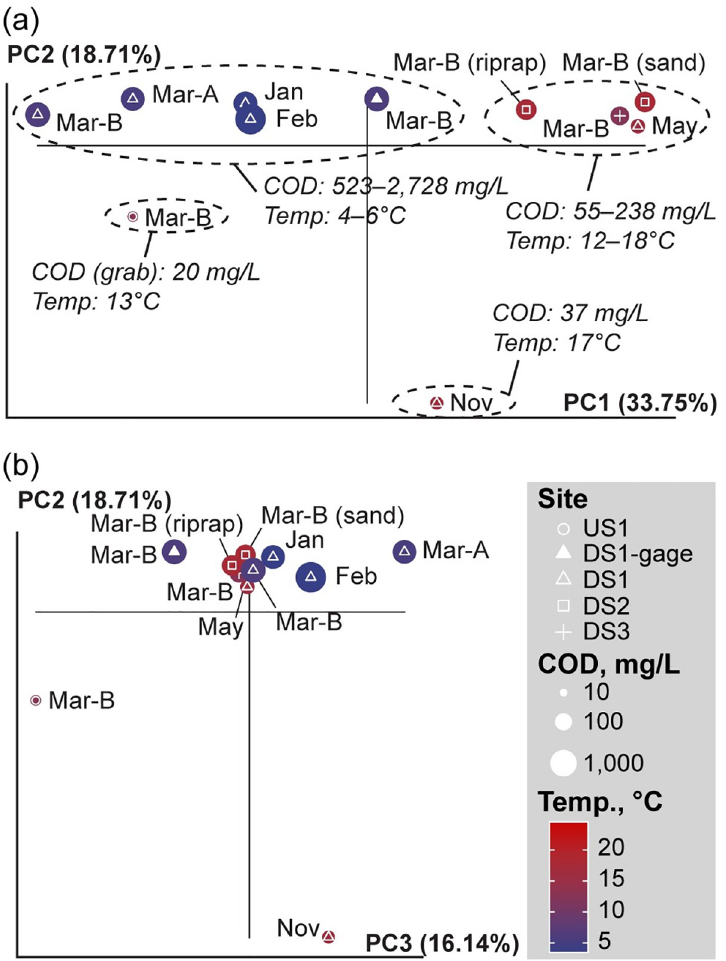
Fig 7. Principal coordinates analysis plot showing differences in biofilm community composition, based on PhyloChip results. (a) axes 1 and 2, and (b) axes 2 and 3. White symbol shapes distinguish sampling sites; point size reflects the log-10 mean 2-week flow-weighted COD concentration at each site (except at US1 site, where only grab samples were available); point color reflects the maximum 2-week temperature at each site.